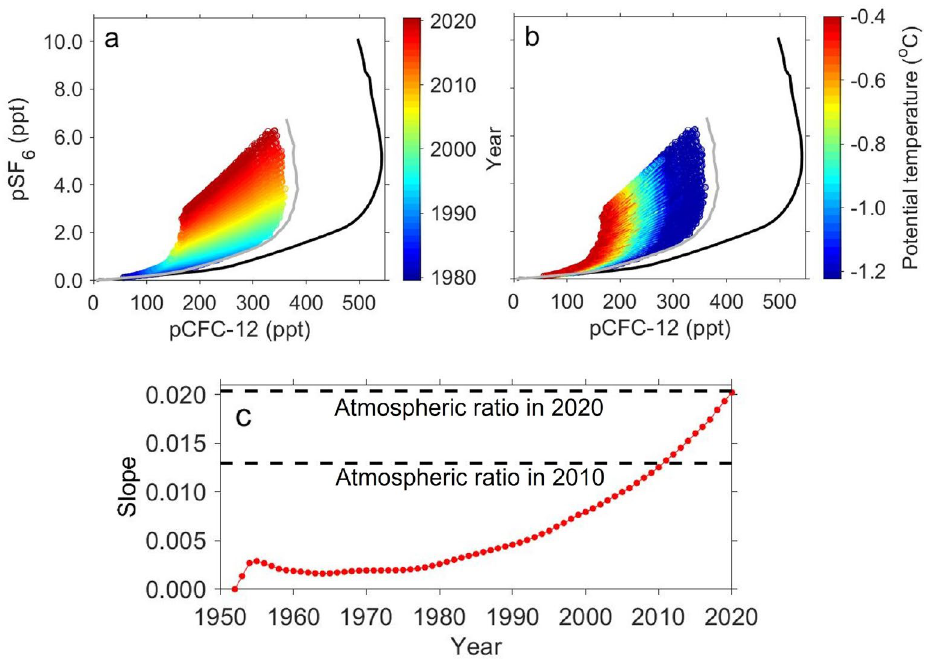
Figure 5. Relationship between simulated pCFC-12 and pSF 6 in new AABW (in the region near the Cape Darnley polynya; 63°–67°S, 60°–68°E, neutral density: γ n > 28.27 kg m −3 , θ < − 0.4 °C) 10 . Data are averaged over January–December for each year. In ( a,b ), data from 1980 to 2020 are used. Black and gray lines indicate the year-to-year variations in atmospheric partialpressure and winter (June–August) mean DSW (surface values at Cape Darnley polynya: ≥ 67°S, 65°–70°E), respectively. Colors denote ( a ) year and ( b ) potential temperature. ( c ) Year-to-year variations in the slope of the approximately straight lines based on the relationship between simulated pCFC-12 and pSF 6 in new AABW (red). Dashed black lines indicate the atmospheric pSF 6 /pCFC-12 ratio in 2010 and